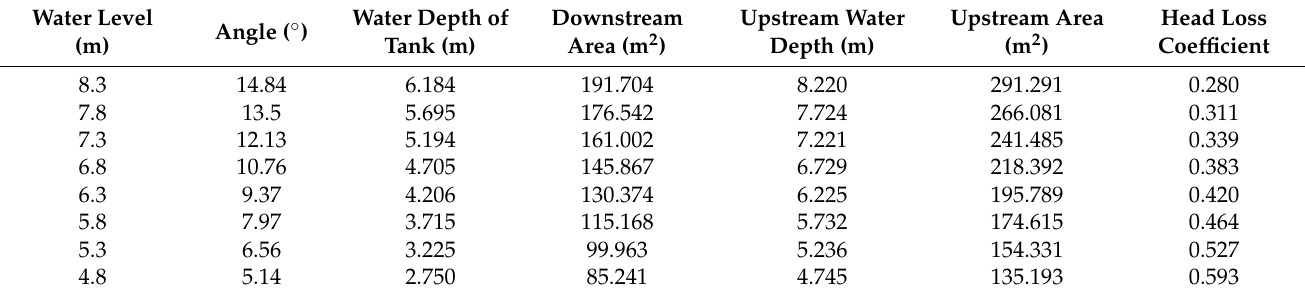
Table 6. Weir head under simulated working conditions.